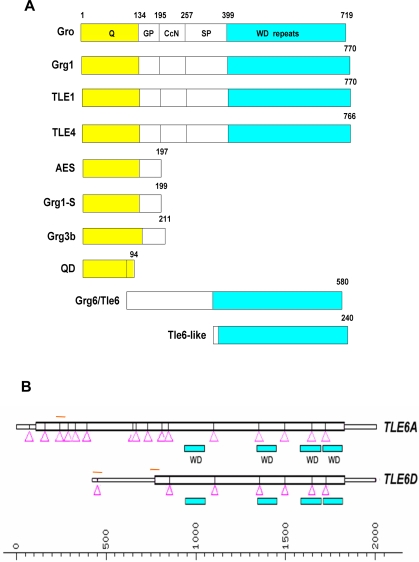
TLE Family.Schematic diagram of TLE protein family members. (A) Numbers indicate amino acids. Q, glutamine rich domain; GP, Glycine/praline rich domain; CcN, domain containing putative phosphorylation sites and putative nuclear localization signal; SP, serine/praline rich domain; WD repeats, domain containing series of tandem repeats of tryptophan and aspartic acid residues. (B) Diagram of TLE6 RNA and alternative splice form TLE6D is indicated. TLE6A is the full length mRNA transcript. Orange bars indicate position of primer sets for qPCR. Arrows indicate exon-exon junctions.